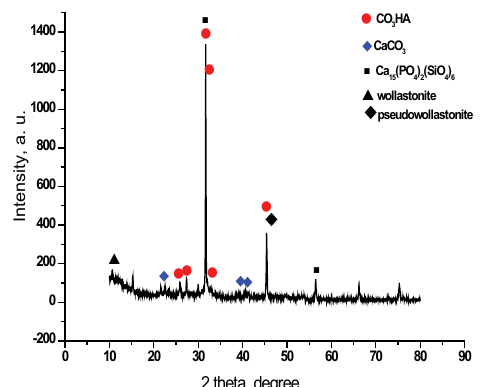
Figure 5. XRD of the 25G:75CPS/W (wt.%) sample immersed in 1.5 SBF for 3 days.